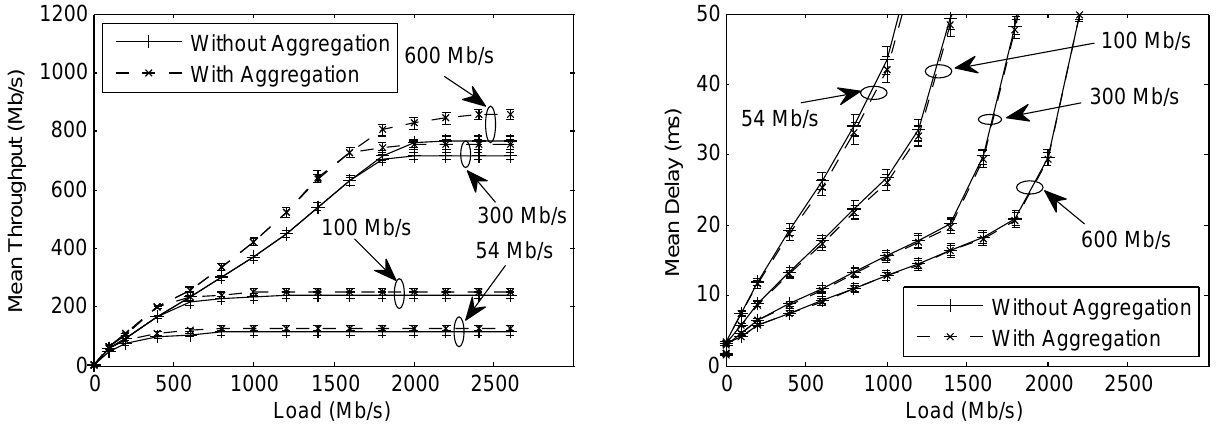
Figure 13. Impact of advanced aggregation techniques on integrated EPON-WLAN network performance for various WMN data rates under triple-play